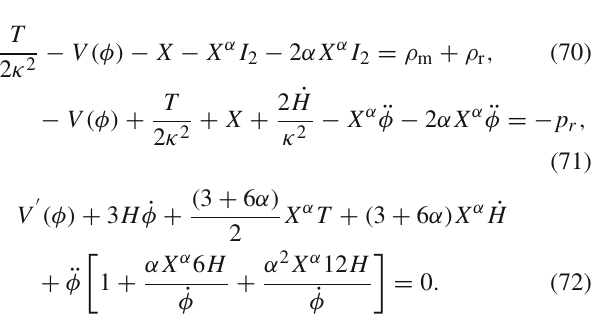
(cid:13) 2 and the right phase portrait is for 9